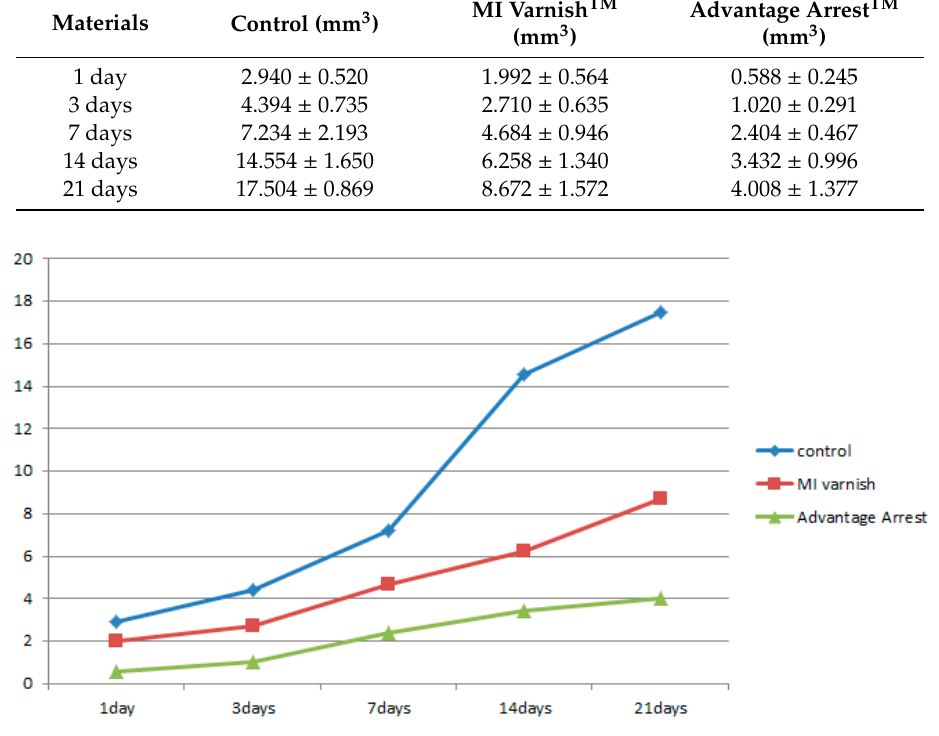
Figure 9. Comparison of the mean demineralized volume change between groups at each time point.